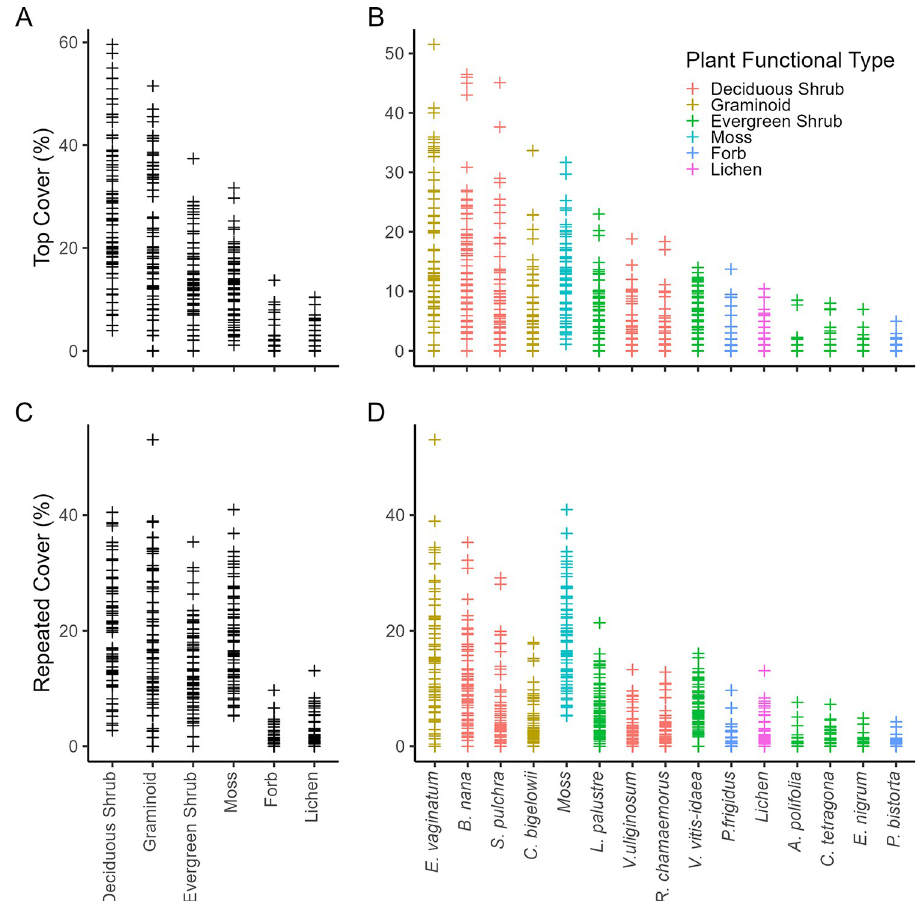
Fig 1. Sample plot vegetation top cover by plant functional type (A) and species (B), and repeated cover by plant functional type (C) and species (D) in the MAT sample plots. Points (plus symbols) are individual plots. Points in (B) and (D) are colored by species’ functional type. Moss and lichen were not identified to